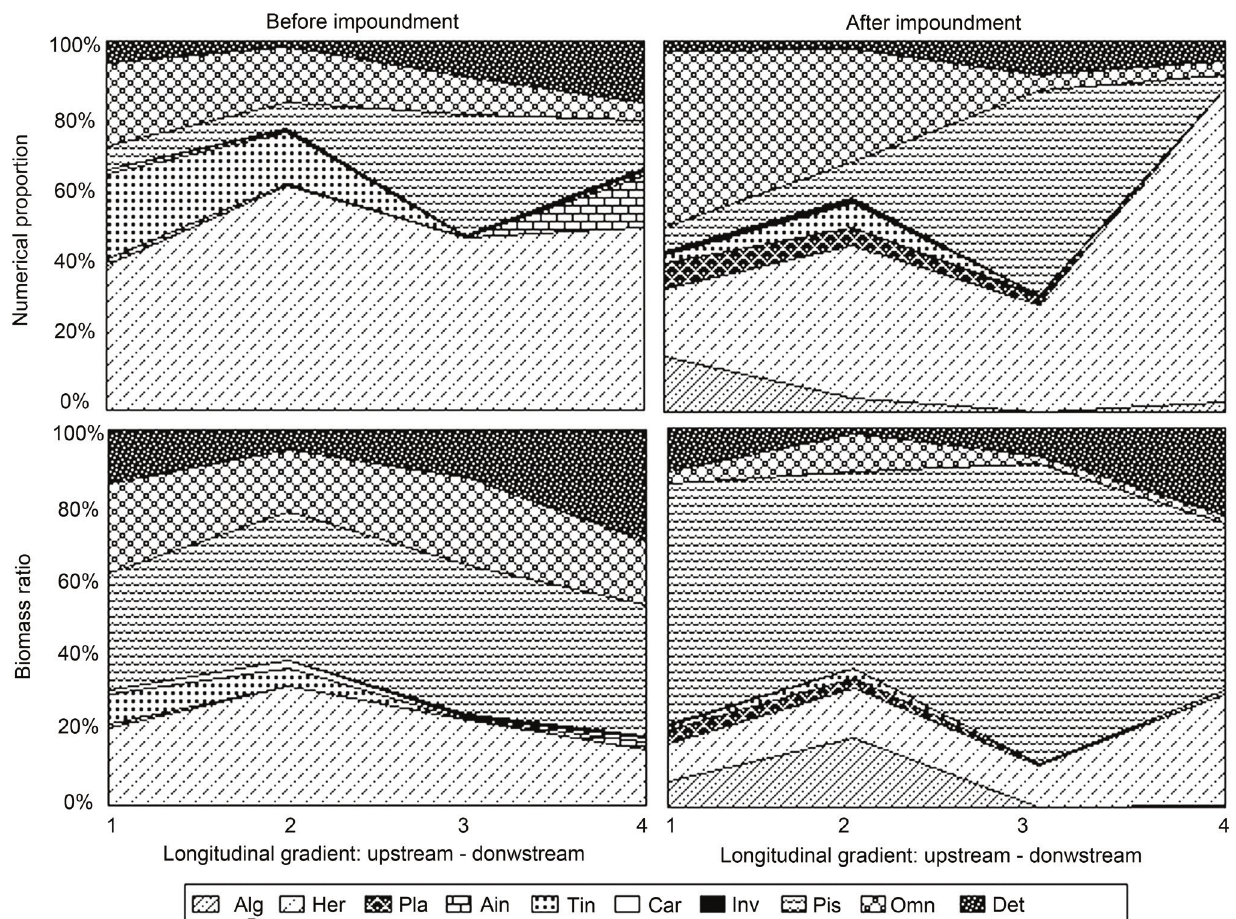
Fig. 3. Proportion in number and biomass (CPUE) of the trophic guilds along the longitudinal gradient of the Salto Caxias Reservoir, Iguaçu River, before and after the impoundment. (1 = upstream; 2 = middle region; 3 = dam; 4 = downstream) (Alg = algivores; Det = detritivores; Her = herbivores; Ain = aquatic insectivores; Tin = terrestrial insectivores; Inv = invertivores; Omn = omnivores; Pis = piscivores; Pla = planktivores; Car =